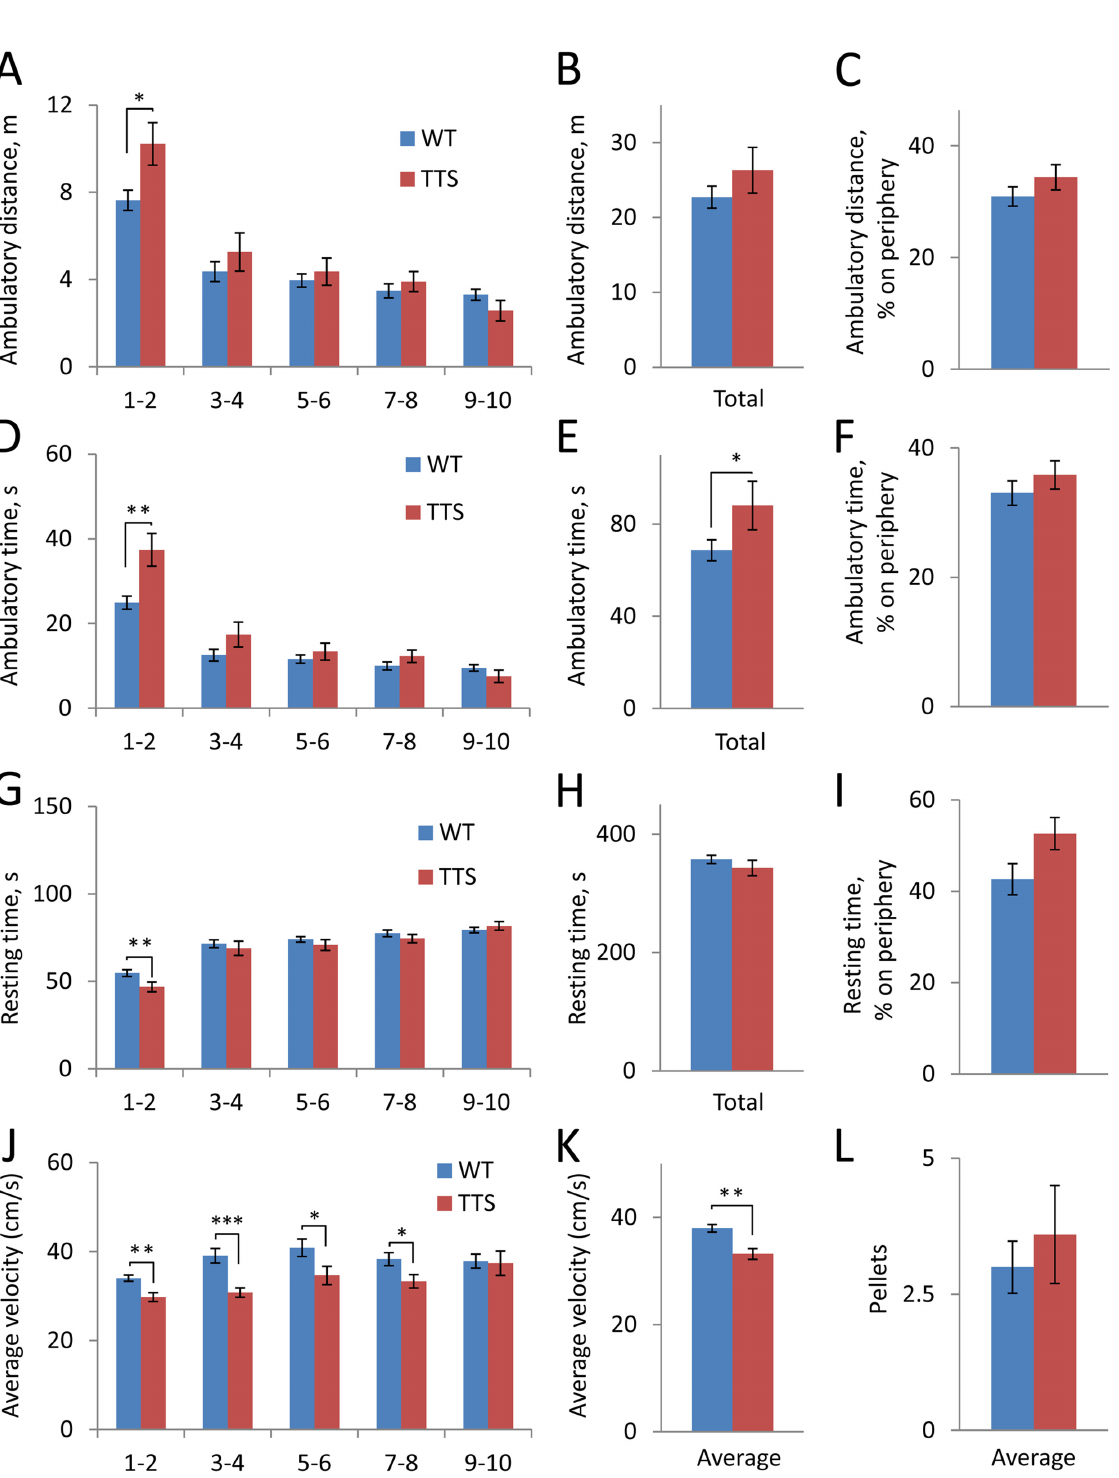
PLOS ONE | DOI:10.1371/journal.pone.0134861 July 31,